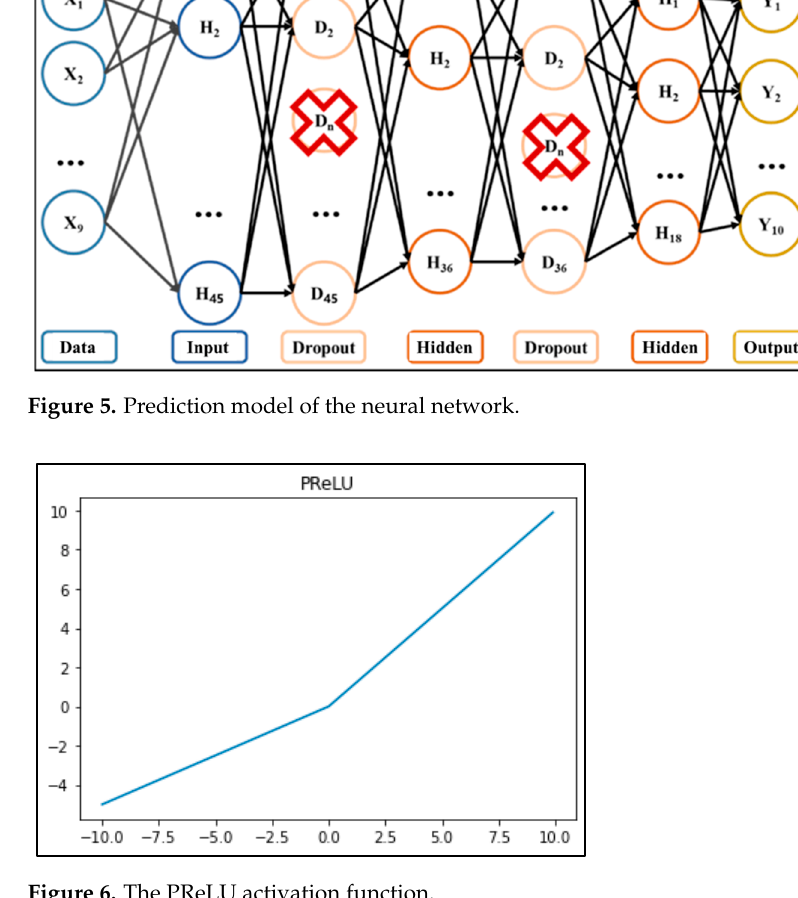
Figure 6. The PReLU activation function.